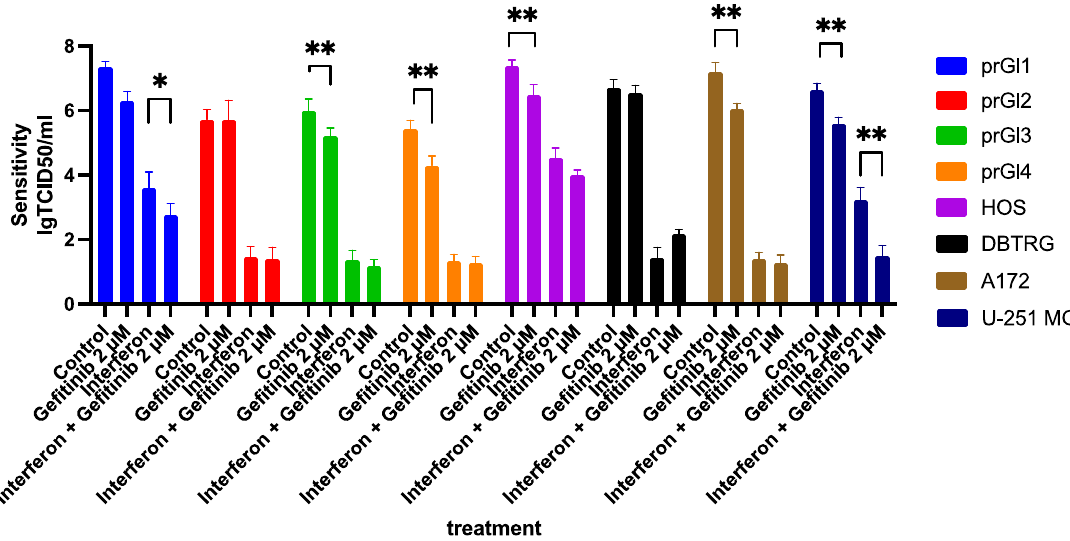
Figure 8. Replication efficiency of VSV on standard and primary glioma (prGl) cell lines, treated with gefitinib (2 µ M), interferon α 2 β (1000 U/mL), and simultaneous treatment of gefitinib and interferon, each for 24 h. Gefitinib alone inhibited viral production in all cell lines except DBTRG-05MG and prGl2. Gefitinib treatment has shown a synergic effect with interferon treatment, inhibiting viral production in prGl1 and U-251 cells. ( n = 3 replicates per group). Bars represent mean values with SD, * p < 0.05, ** p < 0.01, t -test.